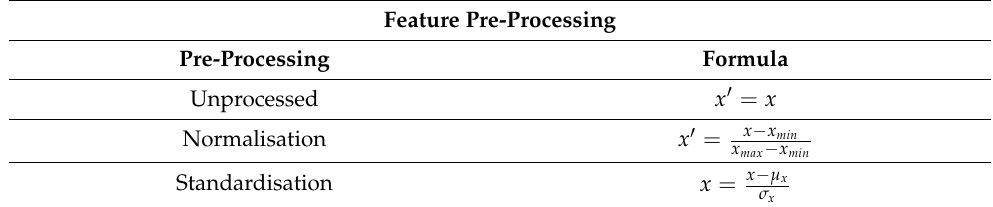
Table 2. Formulas for feature